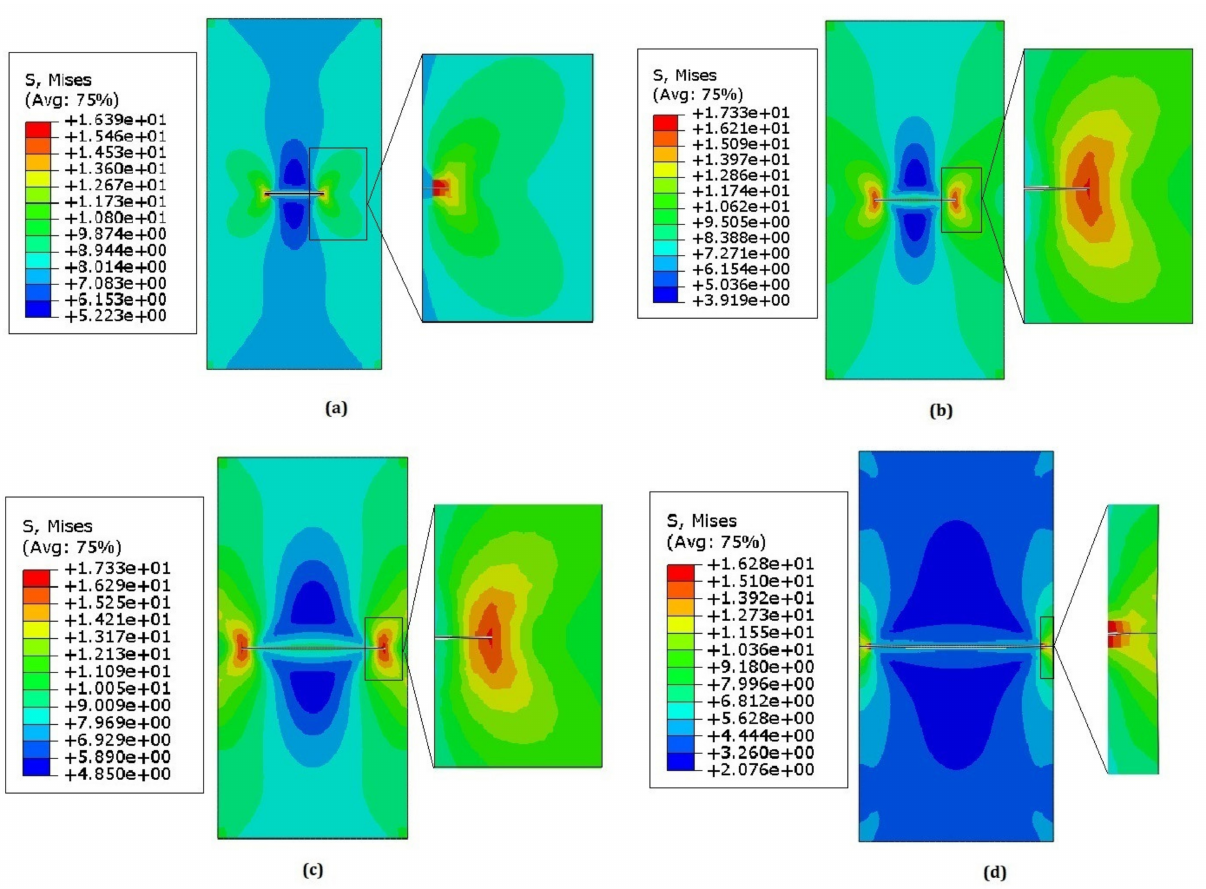
Figure 13. Von Mises stress distribution in center cracked specimen during ( a ) loading ( b ) crack initiation ( c ) crack propagation ( d )